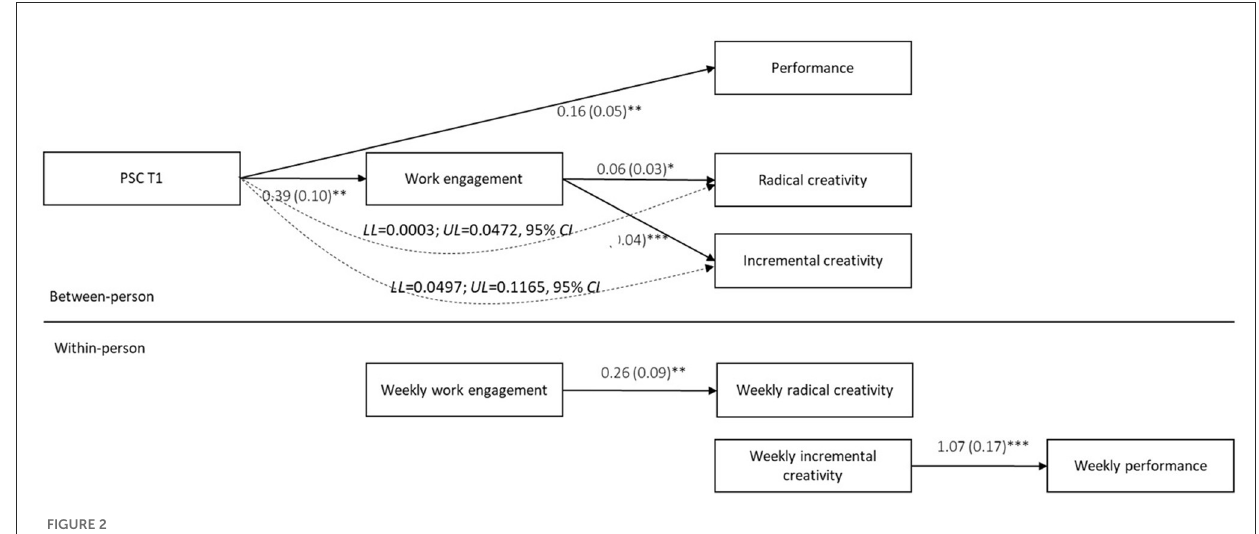
FIGURE2 Results model. * p < 0.05; ** p < 0.01; *** p <